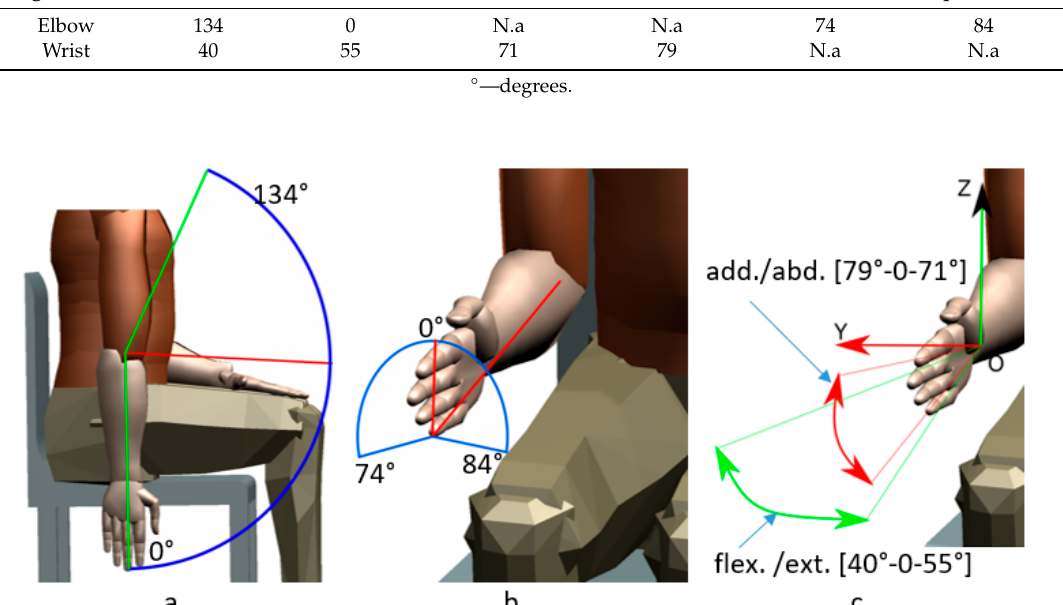
Figure 3. Motion ranges for the elbow rehabilitation module (( a ) flexion/extension, ( b ) pronation/supination) and for wrist rehabilitation device (( c ) flexion/extension/adduction/abduction).